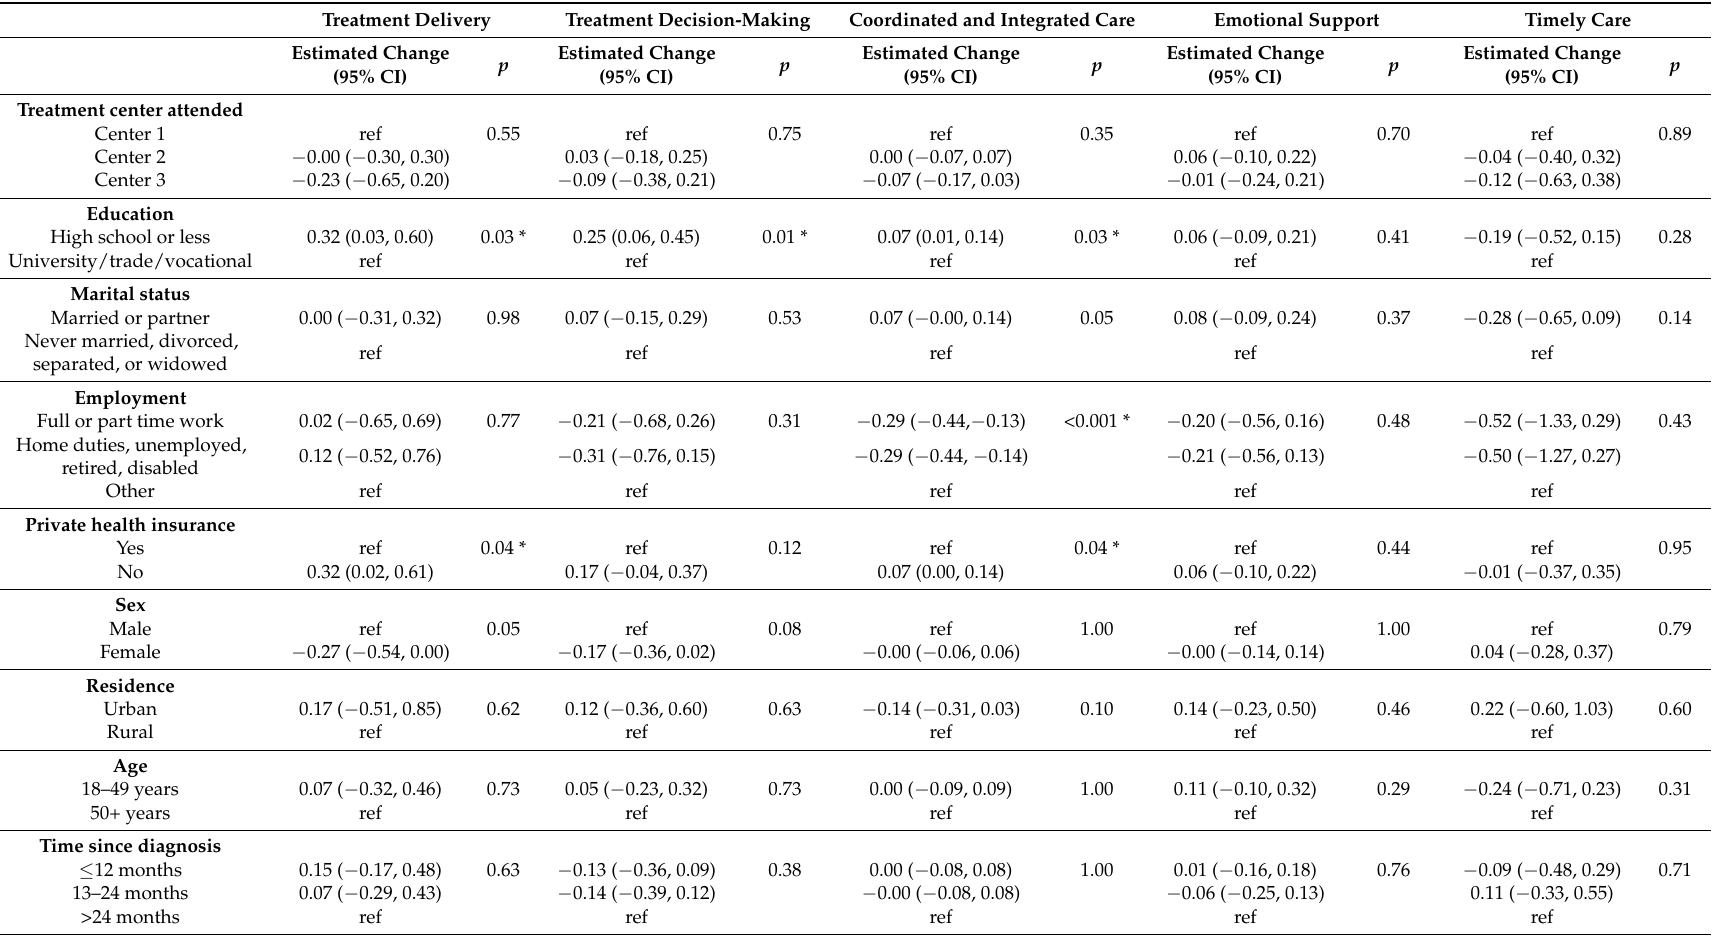
Table 6. Characteristics associated with patients’ perceptions of